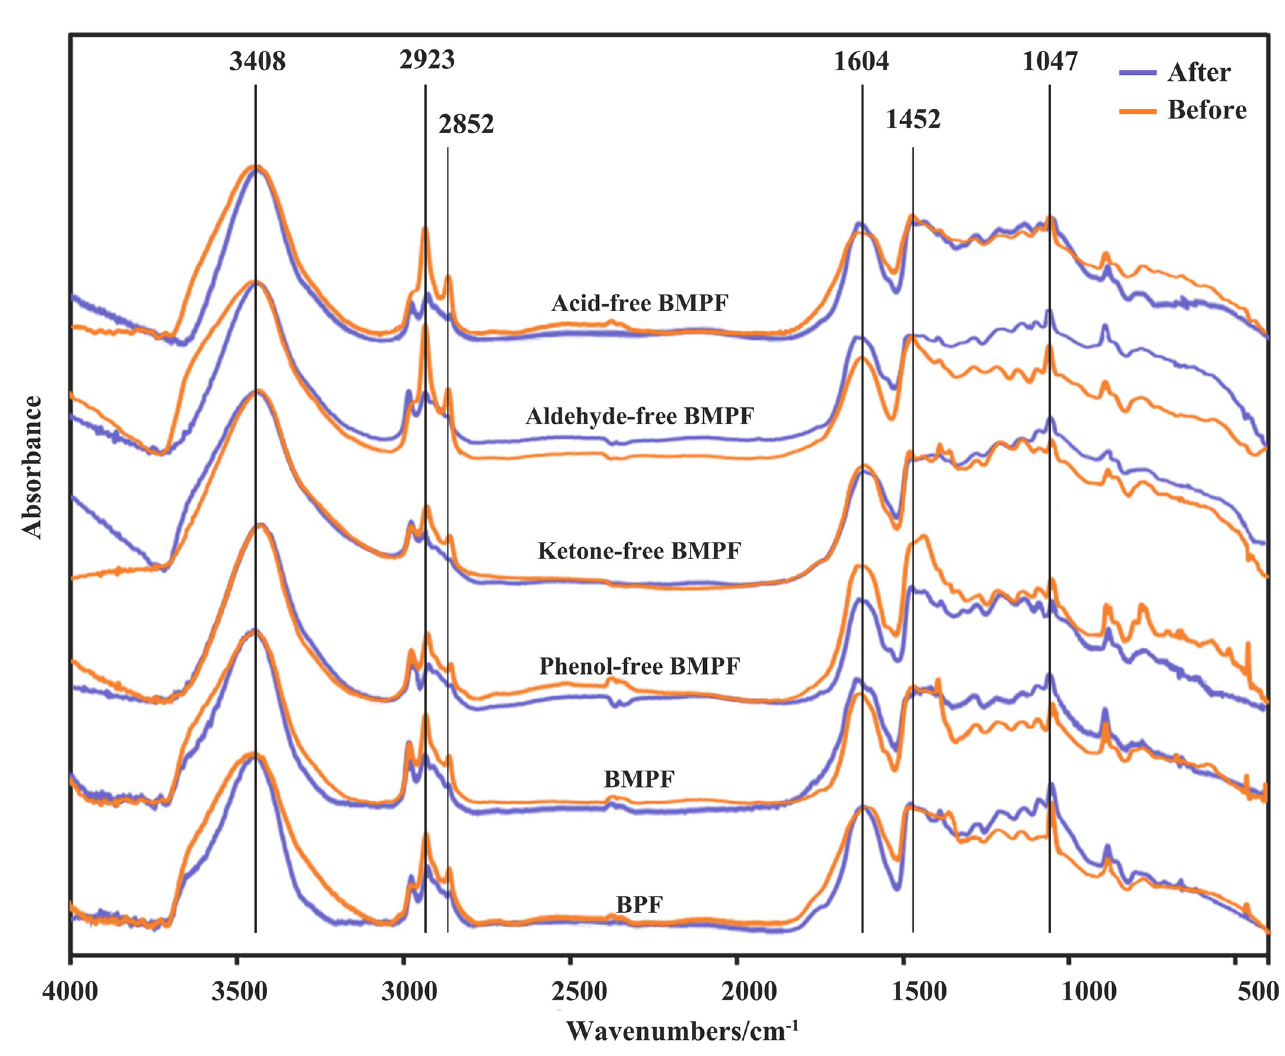
Fig 1. FTIR curves of BMPFs before and after aging for 960 h.